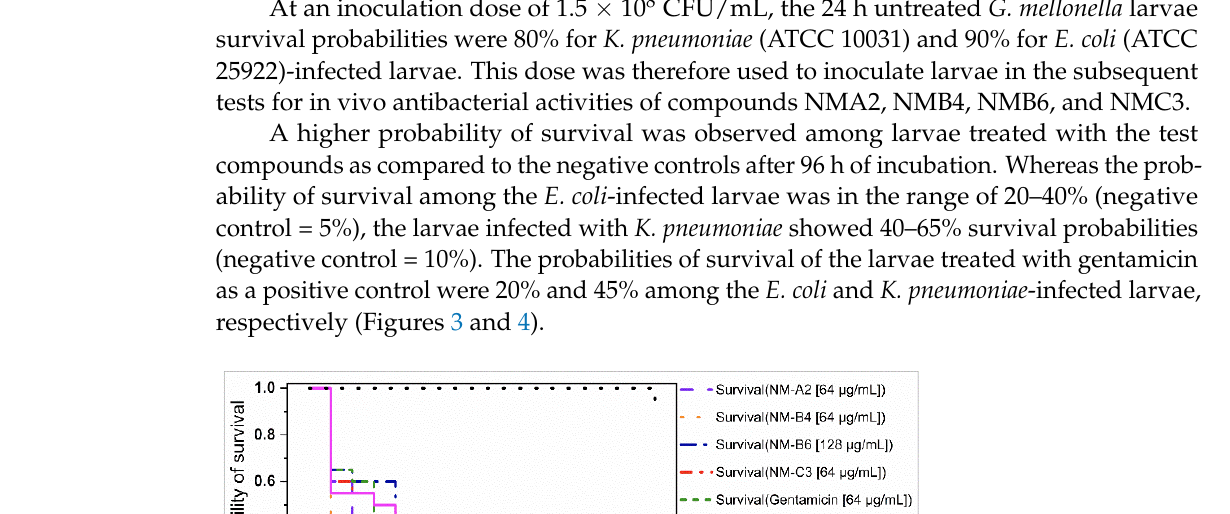
Figure 3. Kaplan–Meier survival plot showing the probability of survival of G. mellonella larvae infected with E. coli (ATCC 25922) and treated with the isolated compounds, as well as positive and negative controls.